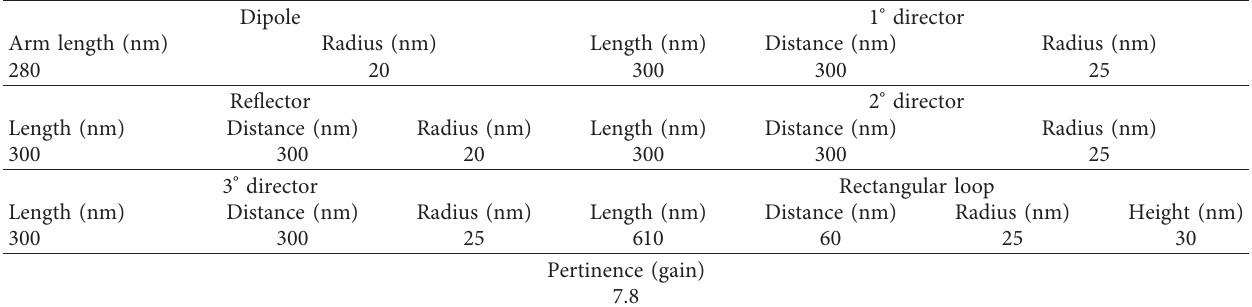
Table 5: Optimal dimensions found by the fuzzy adaptive AGPSO method for YU nanoantenna combined to a rectangular loop. Dipole